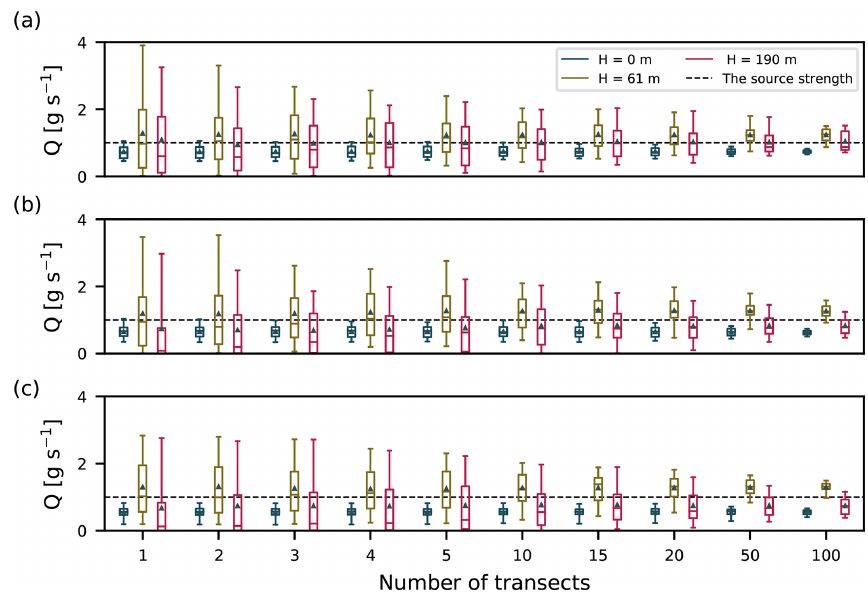
Figure 12. Estimates of the source strength from instantaneous-plume transects for all three emission heights. Boxes show the interquartile range, while the whiskers span from the 5th to 95th percentile of the data and show the mean and median. Distances from the source are